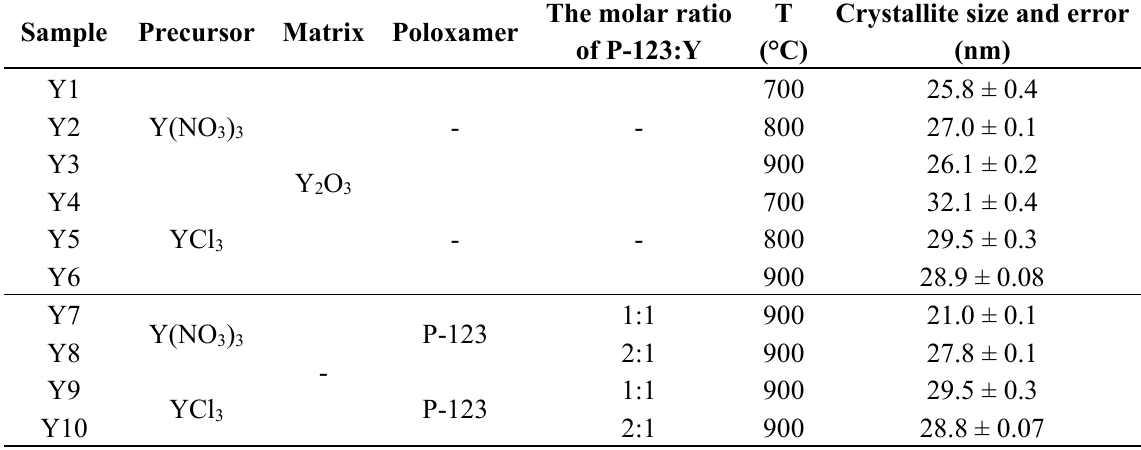
Table 1. Yttrium oxide (Y 2 O 3 ) systems prepared by sol-gel method, key words and general